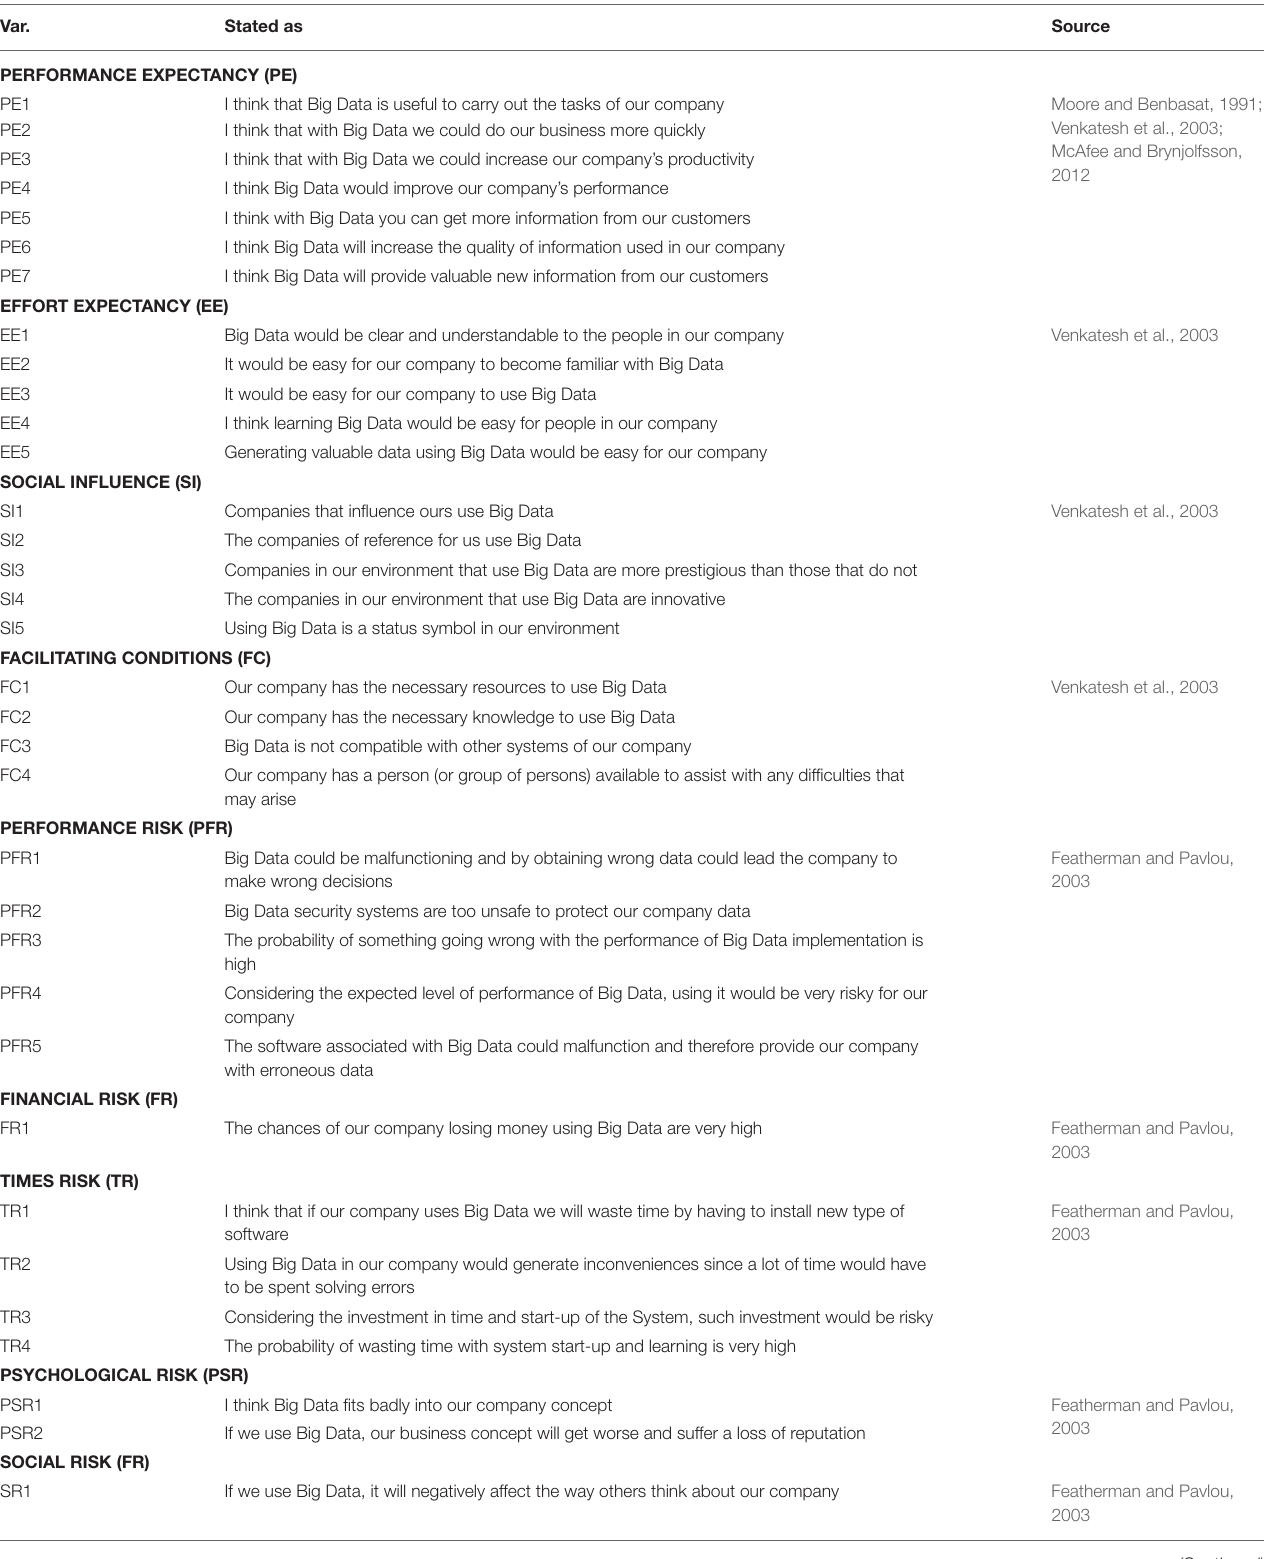
TABLE 3 | Description independent